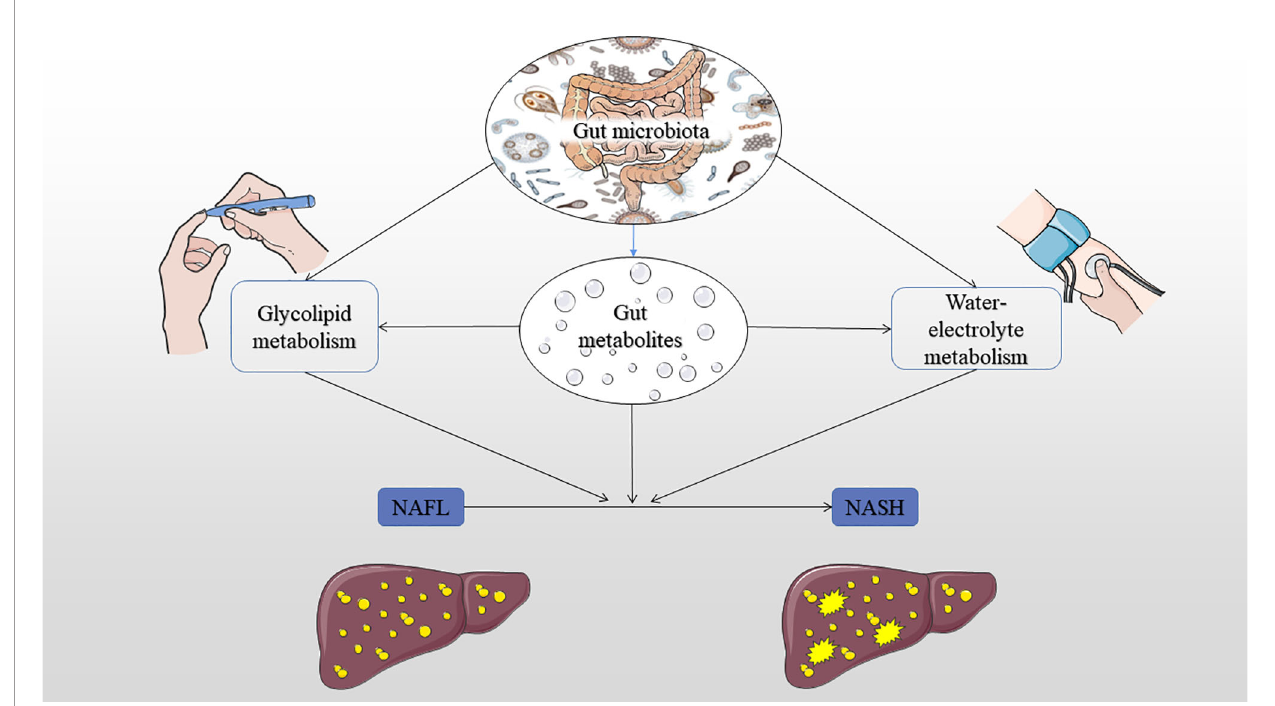
FIGURE 4 | Summary of the hypothesis mechanism process of gut microbiota, glucose, lipid, and water-electrolyte metabolism on NAFLD pathophysiology. IR, insulin resistance; NAFL, nonalcoholic fatty liver; NASH, nonalcoholic